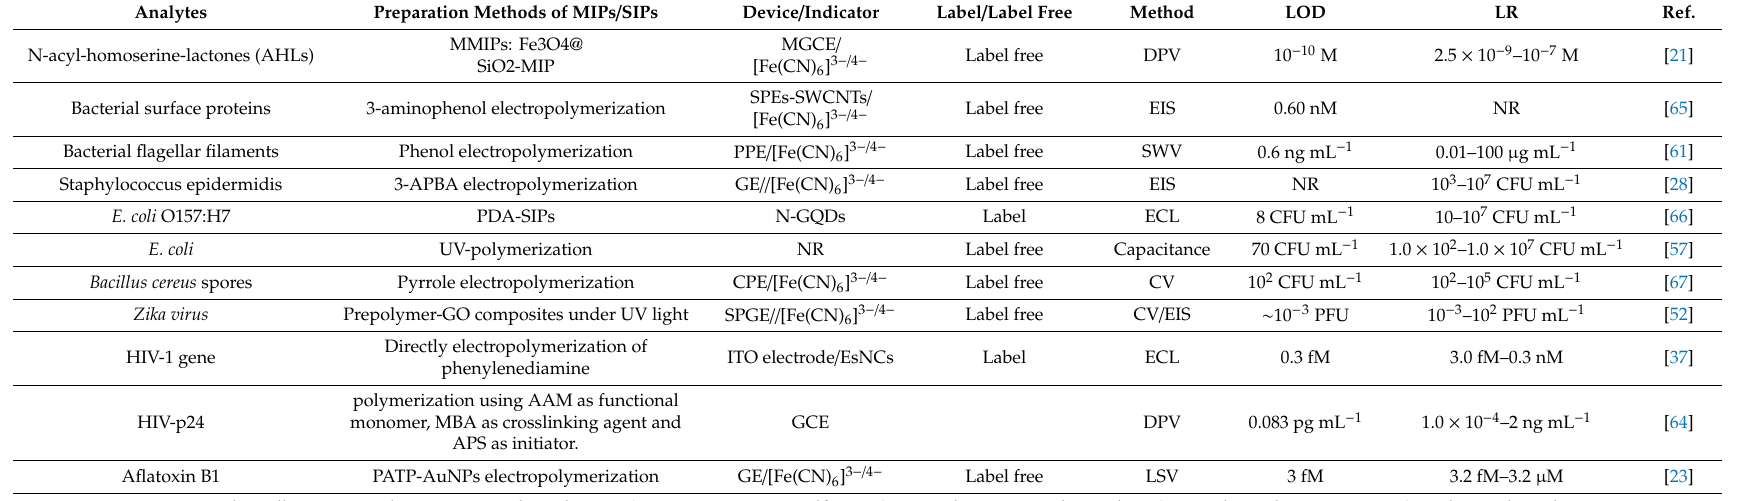
Table 1. Analytical performance of MIPs / SIPs based electrochemical biosensors for infectious